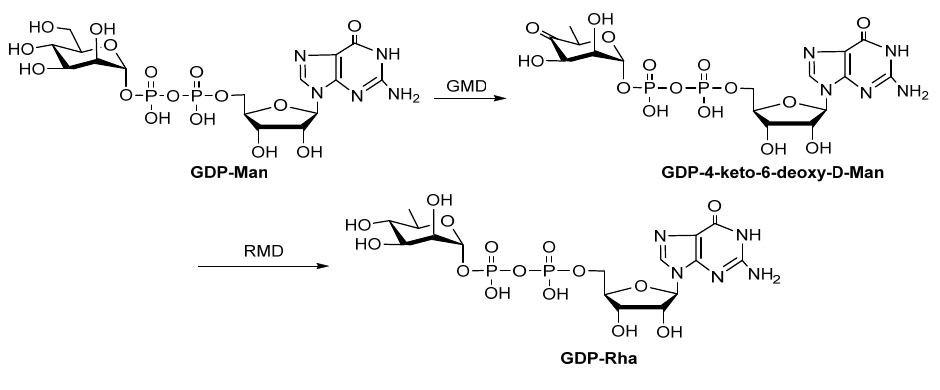
Figure 7. Biosynthesis pathway of GDP-Rha